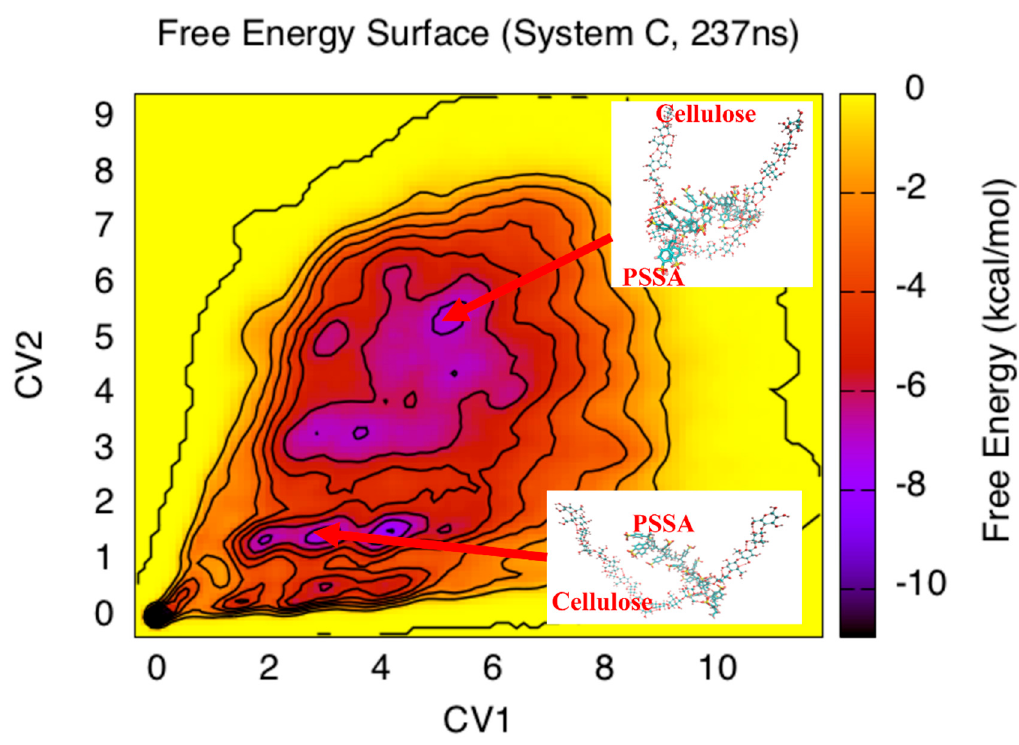
Figure 7. The 2D free energy surface contour plot for system C involving DP 20 neutral PSSA and DP 20 cellulose chains in [EMIM]Cl. CV1 and CV2 represent the numbers of hydrogen bonds formed between them.